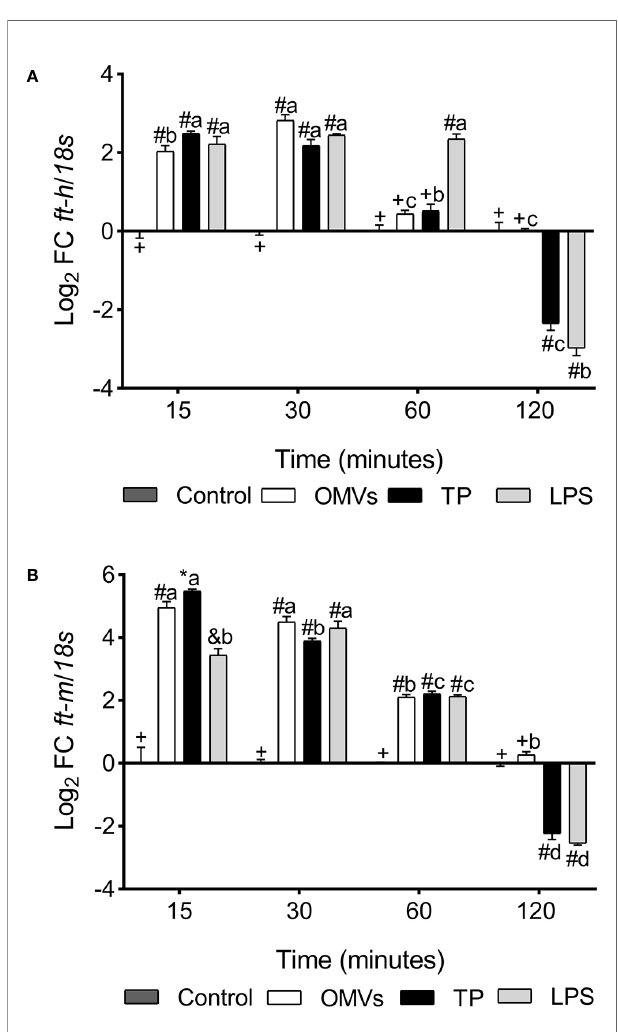
FIGURE 3 | Transcription of ft-h (A) and ft-m (B) in SHK-1 cell line stimulated with 1 m g each PAMPs of P. salmonis at 15-, 30-, 60- and 120-minutes post- stimulation. Expression analysis of mRNA was performed by qPCR and 18s was used for normalization. Symbols over the bars indicate statistical differences between the different treatments at the same time points. Different letters indicate statistical differences in the same treatment at different times. Two-way ANOVA, p < 0.05;